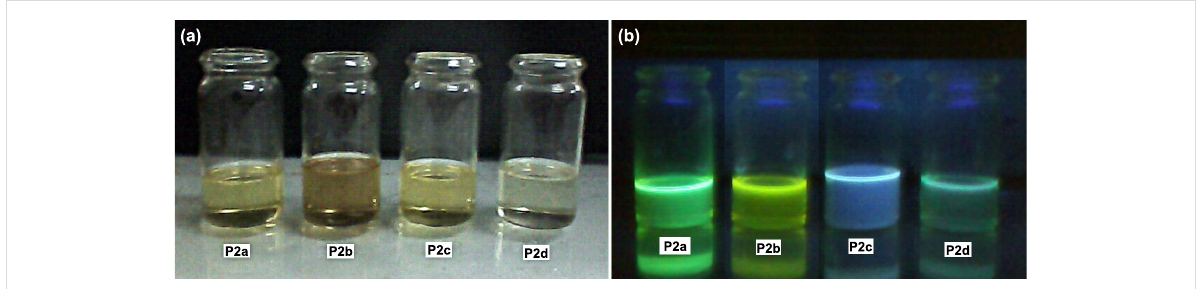
Figure 8: (a) Polymers of P2 series in visible light; (b) observed fluorescence (CHCl 3 dilute solutions) under UV irradiation (254 nm).